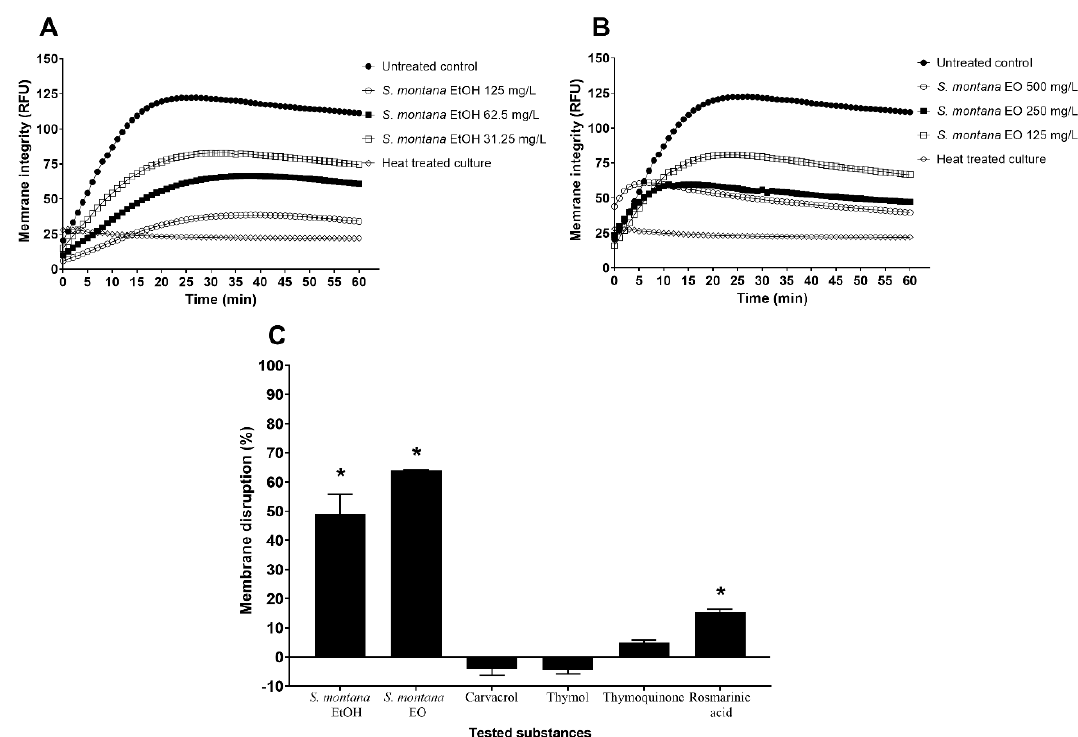
Figure 3. Effect of S. montana ( A ) ethanolic extract (EtOH) and ( B ) essential oil (EO) on membrane integrity disruption of C. jejuni 11,168 in sub-inhibitory concentrations of 0.5 × (125 and 500 mg/L), 0.25 × (62.5 and 250 mg/L), and 0.125 × (31.25 and 125 mg/L) of the minimal inhibitory concentration (MIC), presented in relative fluorescent units (RFU) measured for 1 h in 1 min intervals. A higher value presents higher accumulation of ethidium bromide and thus a lower activity and inhibition of C. jejuni efflux pumps. The disruption of C. jejuni membrane ( C ) in the treated culture compared to the untreated culture, is shown for S. montana ethanolic extract and essential oil, and 6 pure compounds, at the subinhibitory concentration of 0.25× MIC as the percentage (%) of disruption. Membrane disruption of p -cymene and γ -terpinene could not be measured because of autofluorescence of compounds. *, p < 0.05 (Student’s t -test).